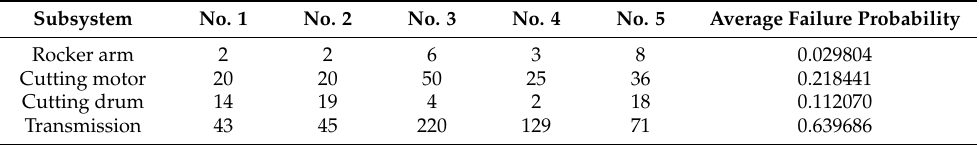
Table 3. Average failure probability of cutting subsystems in shearer.